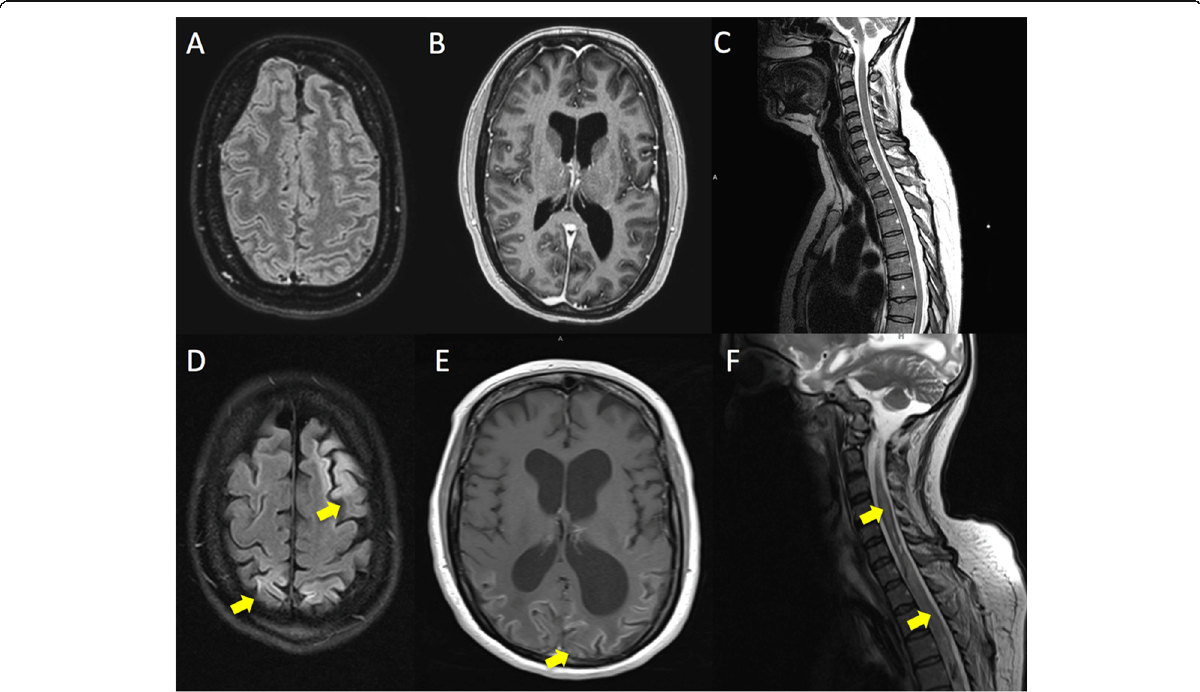
Fig. 1 Axial MRI. MRI findings from initial presentation (A-C, D-F) . MRI findings of FLAIR (A, D) , T1-weighted image with Gd enhancement (B, E) and T2w weighted spinal MRI (C, F) . Initial MRI of the brain (A, B) revealed subtle signs of meningitis, MRI of the spinal cord (C) showed no pathological findings. MRI of the brain after admission to ICU (D, E) revealed cortical and subcortical lesions bihemispherically with parieto- occipital emphasis as well as hyperintense signal alterations of the mesial temporal lobes. MRI of the spinal cord (F) revealed expanded oedema of medulla oblongata. (Marked with yellow